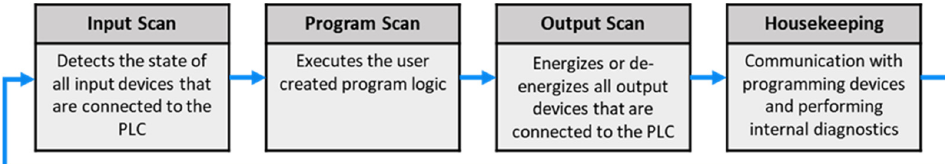
Figure 2. PLC Scan